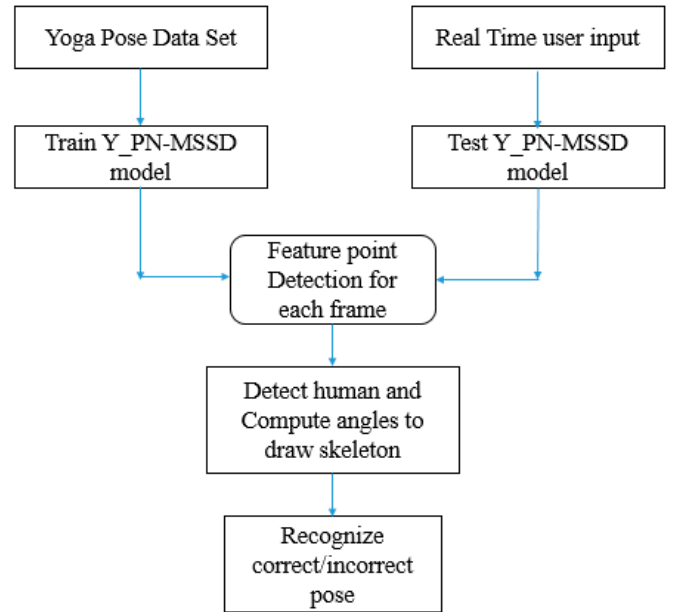
Figure 1. The working of the Y_PN-MSSD model.